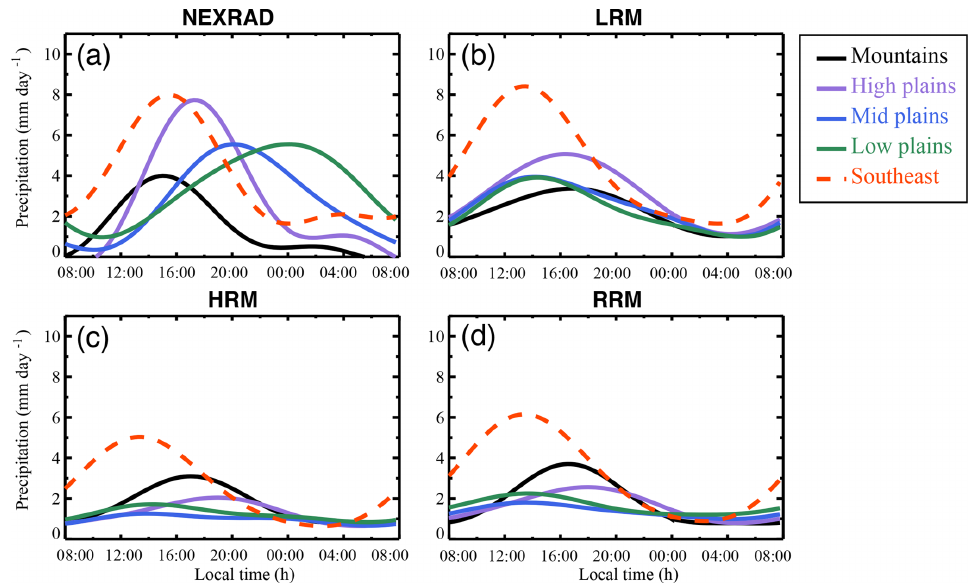
Figure 16. Mean JJA composite precipitation diurnal cycle from the NEXRAD and model simulations for the subregions (denoted in Fig. 15): mountains (black lines), high plains (purple lines), middle plains (blue lines), low plains (green lines), and southeast (red dashed lines). Panels represent (a) NEXRAD, (b) LRM, (c) HRM, and (d) RRM. We first calculate the simple mean diurnal cycle from the hourly time series for each grid box. The first and second diurnal harmonics of the mean diurnal cycle – obtained using fast Fourier transform – are retained and adjusted to local time to generate the composite diurnal cycle. The composite lines plotted here are averages of the composite diurnal cycle in each grid box within the